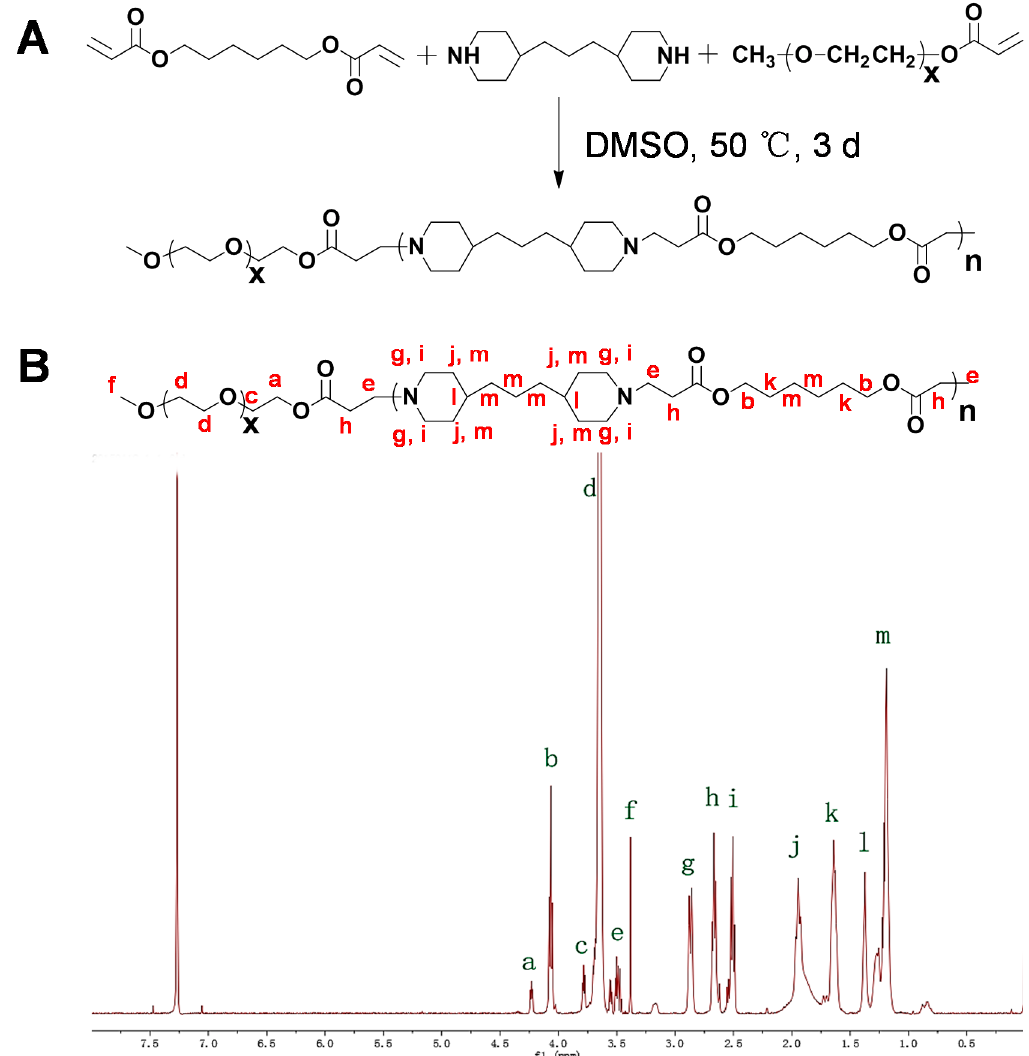
Figure 1. Synthesis of pH-sensitive PHP copolymer ( A ) and its 1 H NMR spectrum recorded on a Bruker AMX 500 NMR spectrophotometer (500 MHz) ( B ).